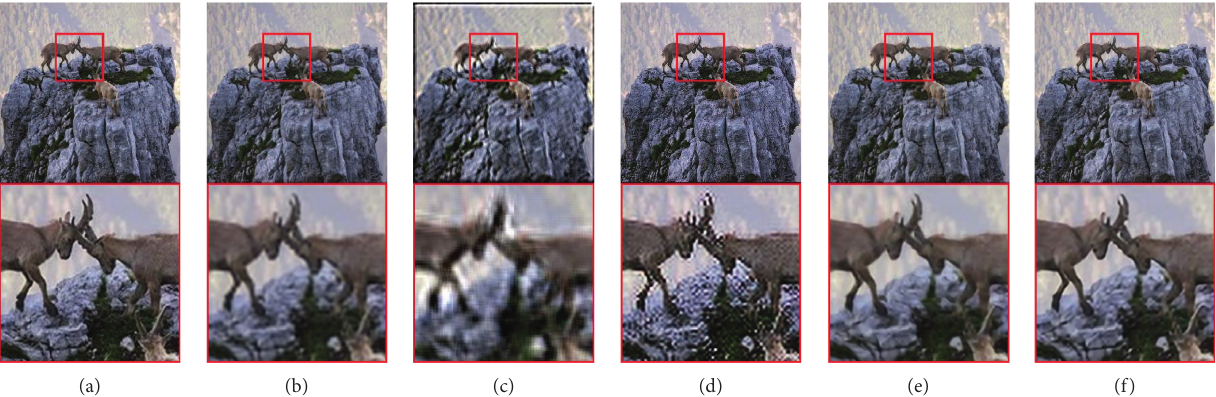
Figure 7: Super-resolution results of the “mountain” image with magnification factor 2: (a) original high-resolution image; (b) result reconstructed by SRCNN; (c) result reconstructed by FSRCNN; (d) result reconstructed by SRGAN; (e) result reconstructed by RDN; (f) result reconstructed by our